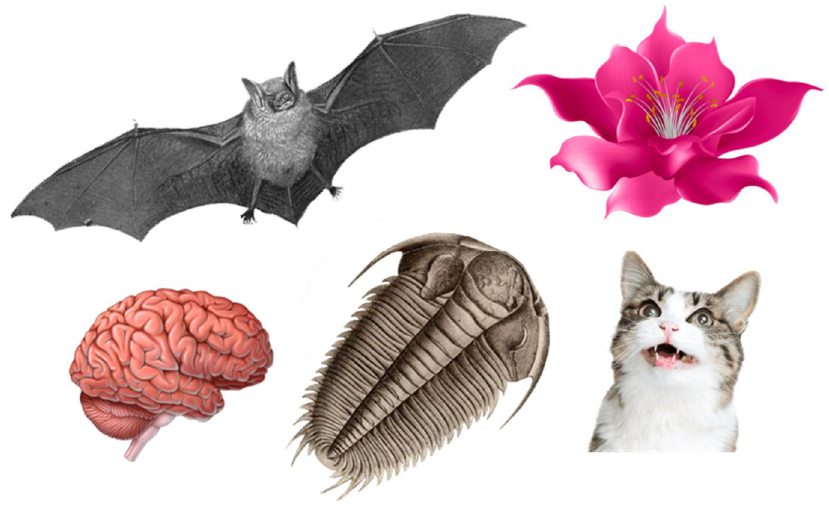
Figure 2. Pictures representing bat echolocation, flowering plants, human intelligence, trilobites, and cat domesticity whose evolutions all defy the neo-Darwinian model.